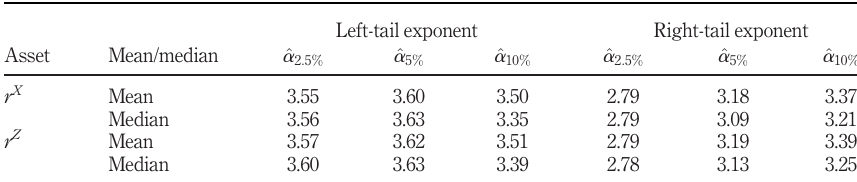
Table III. The Hill tail index estimator Þ ^ a k for the left and right tails